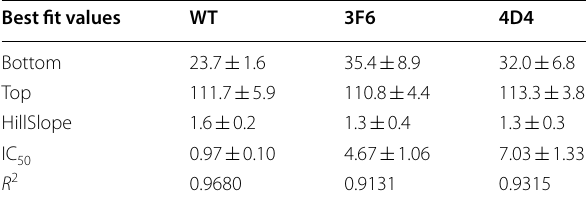
SDS-PAGE, where we saw two distinct protein bands (Additional file 1: Figure S10). We excised the pro- tein band in F2 (larger M w ) and the protein band in F7 (smaller M w ), and conducted proteomic analysis. Mass spectrometry data acquired by LC–MS/MS led to both F2 and F7 matching to the recombinant OsmY-DyP4, with a lower sequence coverage for F7 (71%) relative to F2 (89%). Overlaying identified peptides to the amino acid sequence of OsmY-DyP4 fusion protein (Fig. 6) suggests a potential N-terminal truncation of the F2